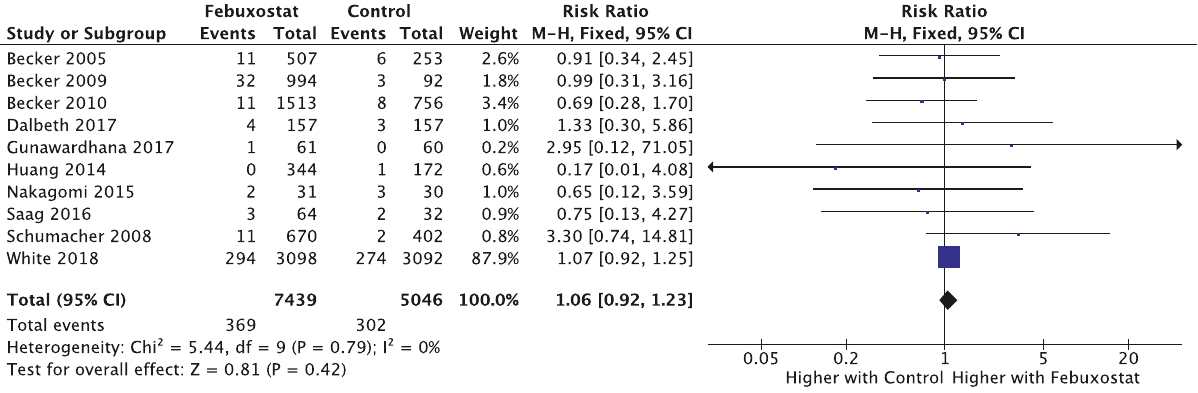
Figure 2: Forest plot of the association between MACE and